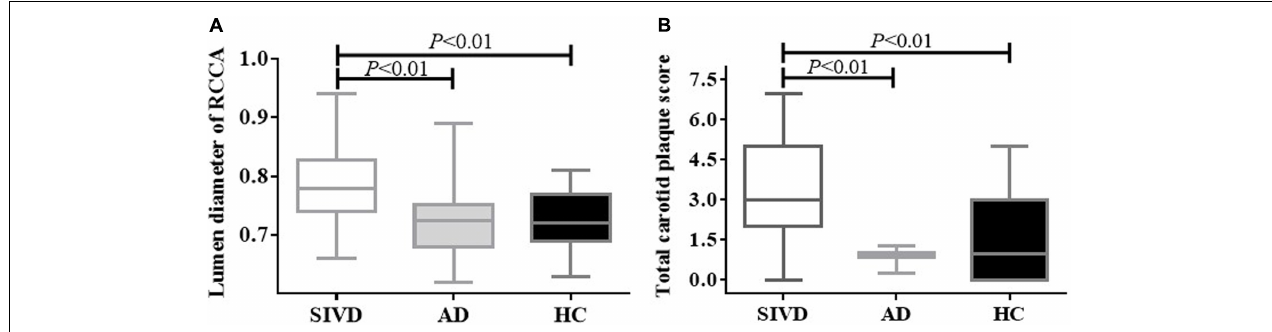
FIGURE 1 | Lumen diameter of the right CCA and total carotid plaque score by the group. Patients with SIVD showed significantly increased lumen diameter (A) and total carotid plaque score (B) compared with the AD and HC groups ( P < 0.01). There was no difference between the AD and HC groups ( P > 0.05). AD, Alzheimer’s disease; CCA, common carotid artery; HC, healthy control; SIVD, subcortical ischemic vascular dementia.